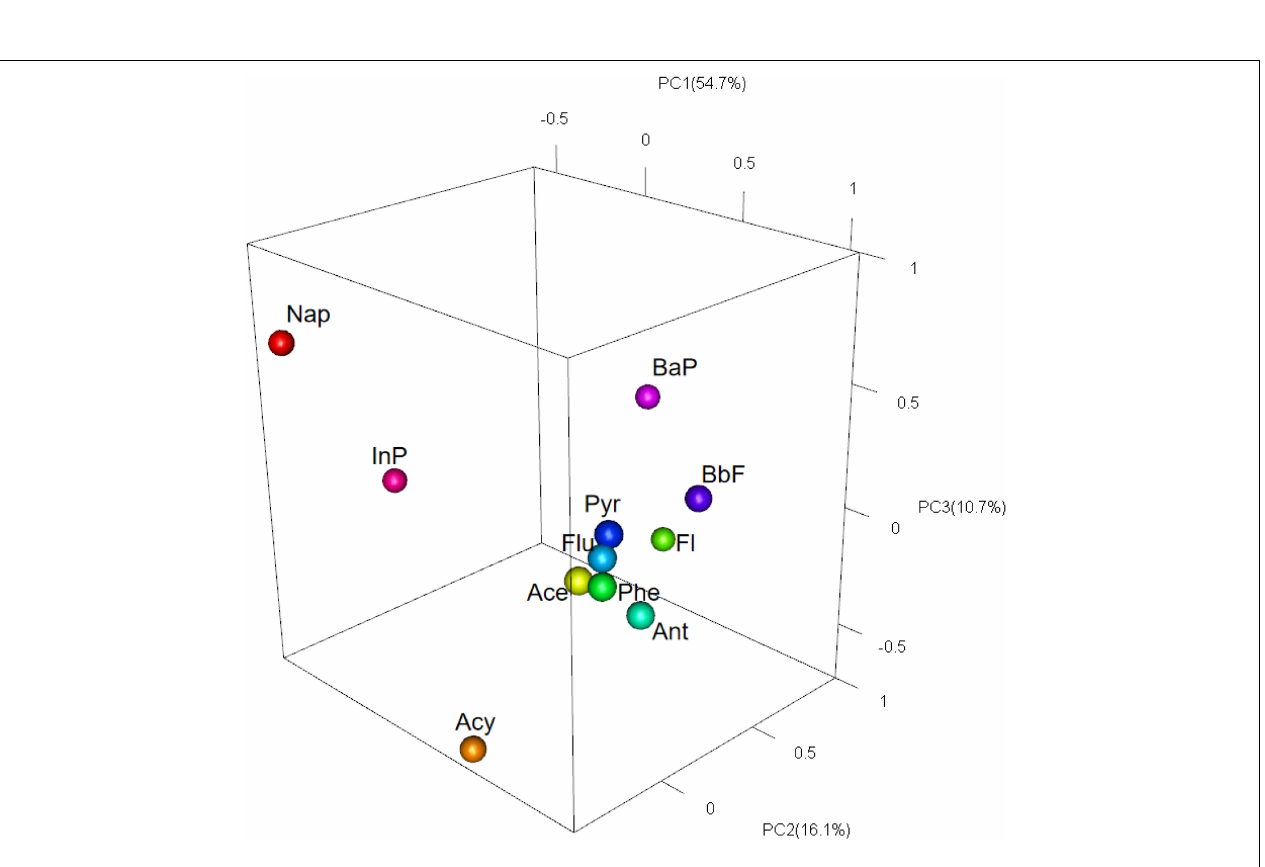
FIGURE 5 | The PCA results of PAHs in the marine